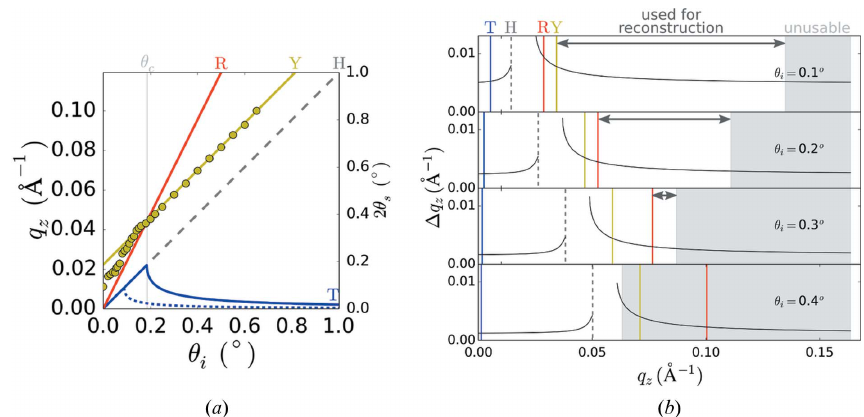
Figure 3 ( a ) Position along the vertical direction detector ( q ) for various experimental features, as a function of grazing-incidence angle ( (cid:4) ), for 13.5 keV X-rays. z i The horizon (H, dashed gray line) is the plane of the sample itself; sub-horizon scattering must transit through the substrate (and suffer from absorption) while scattering above the horizon exits the film and travels through a vacuum. The specular reflected beam (R, red) appears at 2 (cid:4) . When the exit angle i matches the critical angle ( (cid:4) ) of the film or substrate, one observes enhanced intensity on the detector. This Yoneda (Y, yellow) scattering is offset from c the horizon by (cid:4) . The circles are experimental data, where the position of maximum low- q scattering was identified as the Yoneda, for a block-copolymer c thin film on a Ge-coated silicon substrate. The solid yellow line is the theoretical expectation for the critical angle for this substrate. When the incident angle is below the critical angle for the polymer film, the Yoneda shifts to this lower critical angle instead. The transmitted beam (T, blue) is shifted from ¼ 0) because of beam refraction (the dashed line denotes the position of the transmitted beam within the polymer layer). the direct-beam position ( q z ( b ) The refraction distortion ( (cid:2) q ) as a function of position along the detector is strongly nonlinear, and depends on both q and the incident angle ( (cid:4) ). z z i The positions of the various features are denoted by vertical lines: transmitted beam (blue), horizon (dashed gray), substrate Yoneda (yellow), and specular reflection (red). There is a gap in the data between the horizon and the film critical angle. Data close to this gap are generally unusable for reconstruction owing to the large and strongly non-linear distortion. The gray shaded region denotes the area unusable for reconstruction because of the finite range of q sampling (refer to Results and discussion ); the horizontal arrow denotes the span of q used for z z